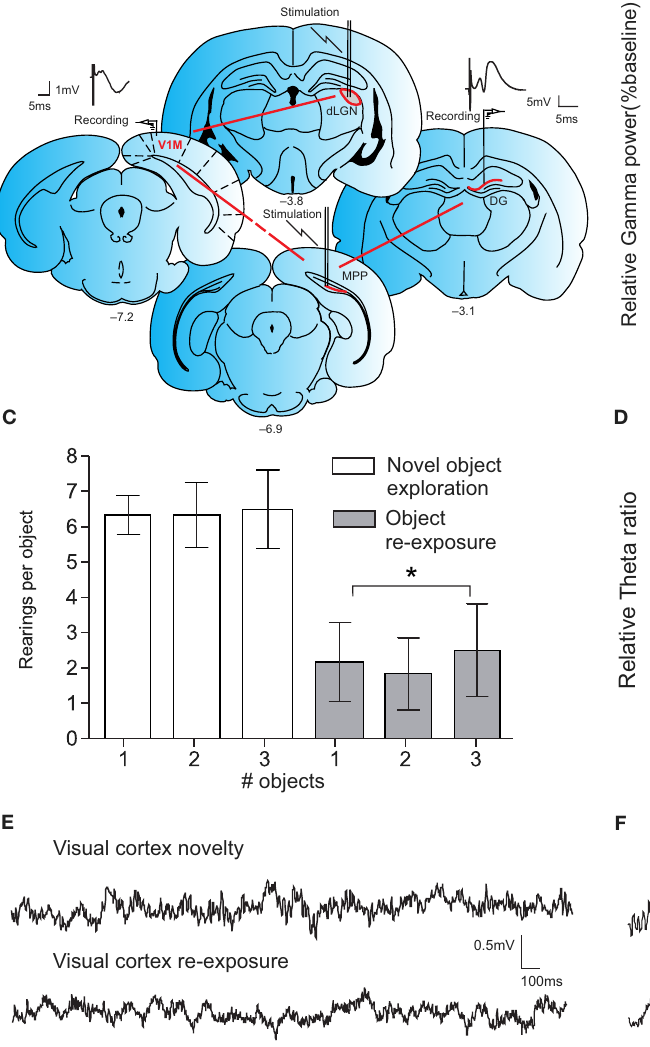
recordings were taken during the circadian illuminance shift. Higher levels of gamma frequencies were observed in VC during the dark phase (indicated with black rectangle) and in the beginning of the light phase (white rectangle) of the night:dark cycle; standard errors of the mean values were used for the error bars; * p < 0.05. (C) Behavioral arousal in response to novel object exploration (white) and re-exposure to the same objects 5 days later (grey) measured by number of rearings per object. (D) Comparison of theta-ratio in dentate gyrus during exploration of novel objects ( n = 4) and the re-exposure ( n = 4) to the objects in the same confi guration. The decrease of cortical gamma activity is paralleled by a drop in hippocampal theta-ratio. A transient increase in theta activity in the dentate gyrus also occurred as a consequence of the illuminance change; * p < 0.05. (E) Original traces of fi eld potential recordings in the VC during the novelty exploration-induced theta period (upper trace) and re- exposure (lower trace). (F) Original traces of fi eld potential recordings in the DG during the novelty exploration-induced theta period (upper trace) and re- exposure (lower